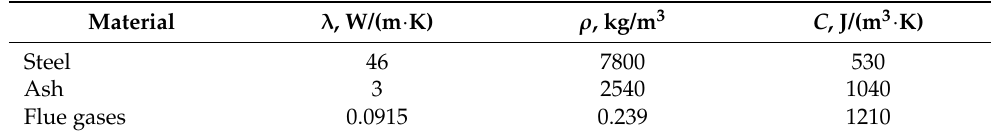
Table 8. Components’ thermophysical properties in the system of steel tube/ash layer/heated flue gases.